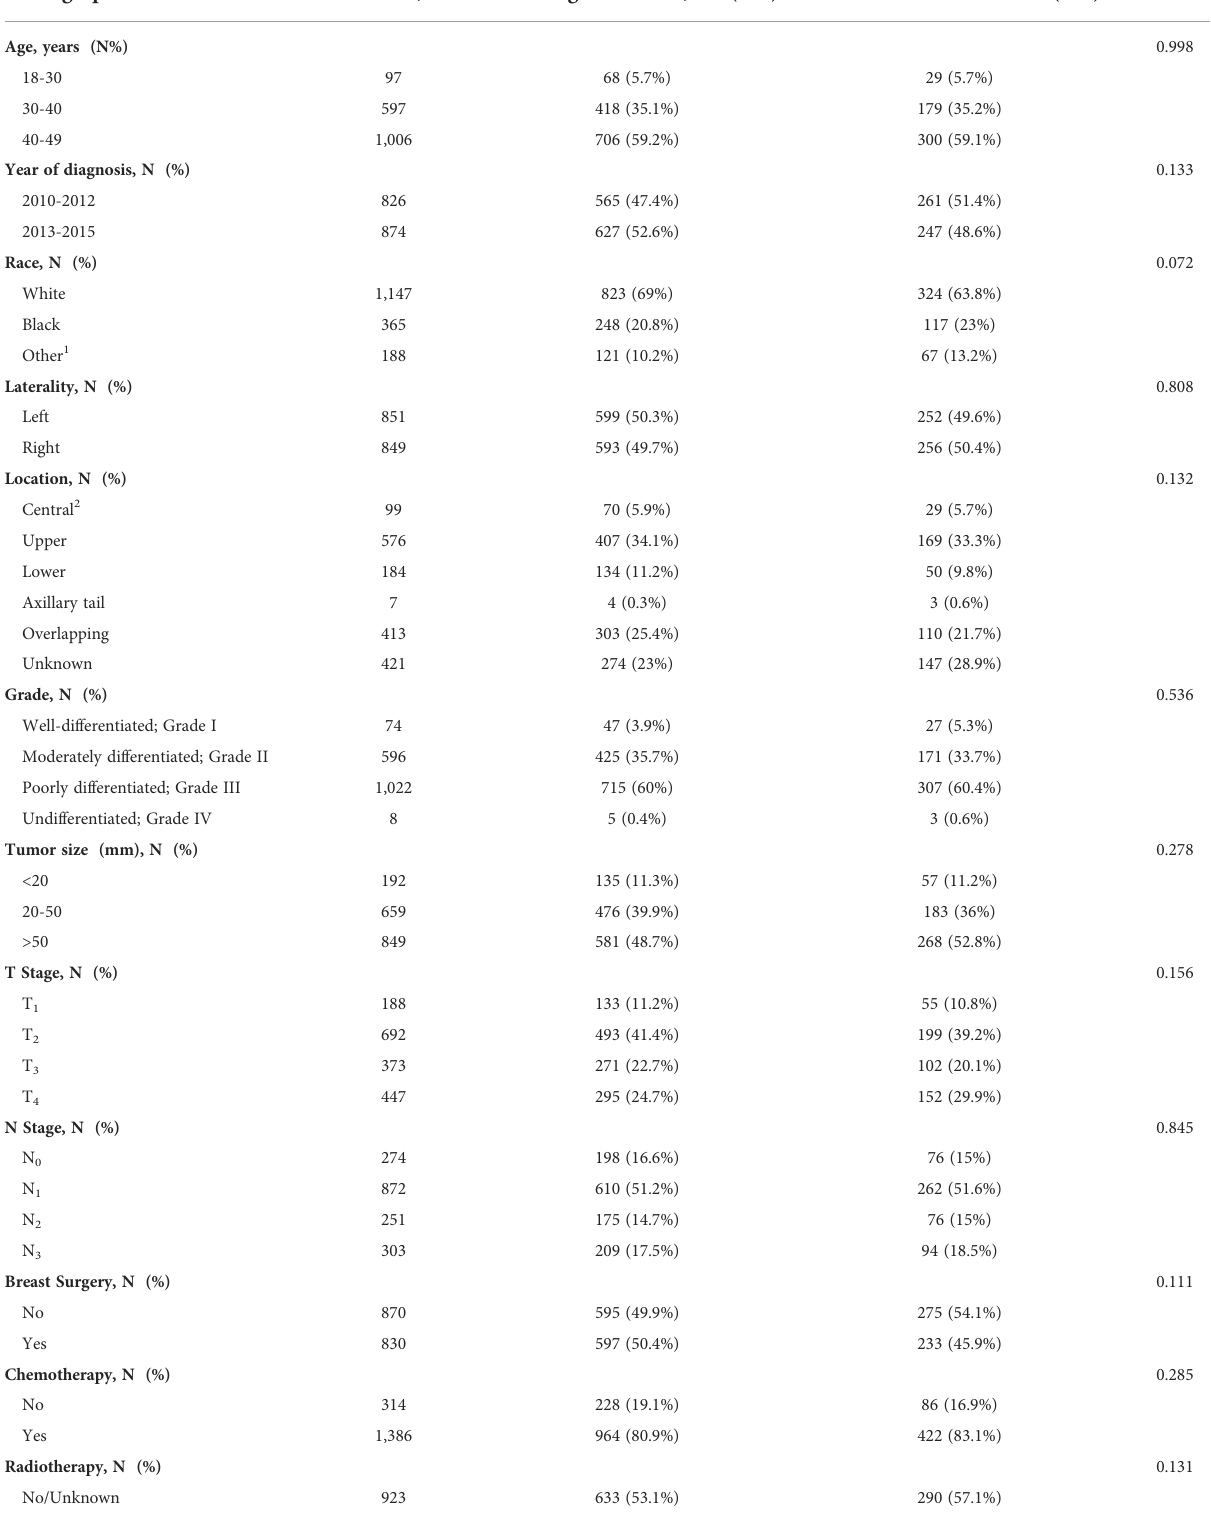
TABLE 1 Summary of the demographics and clinicopathologic characteristics of the patient